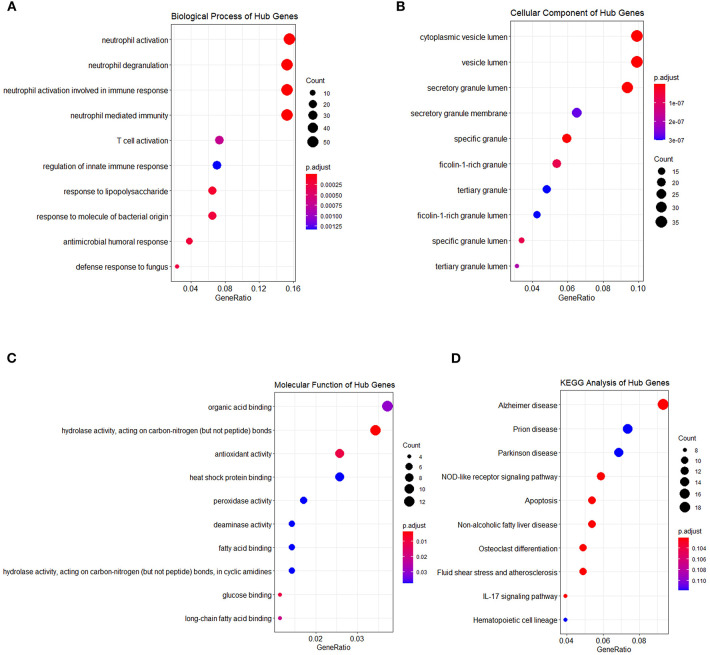
Functional enrichment analysis of hub genes. Hub genes were also subjected to enrichment analysis, categories are shown in (A) biological process, (B) cellular component, (C) molecular function, and (D) KEGG pathway, respectively. The dot size represented the count of differentially expressed genes, and the color depth represented the p-value-based significance.